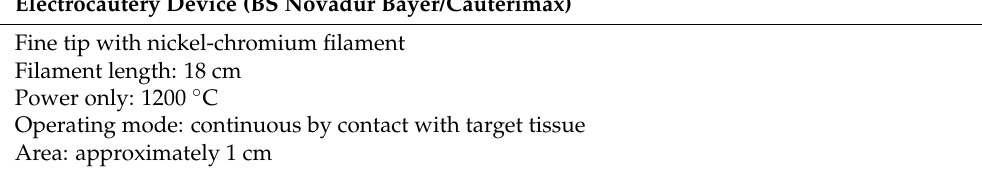
Table 1. Parameters for